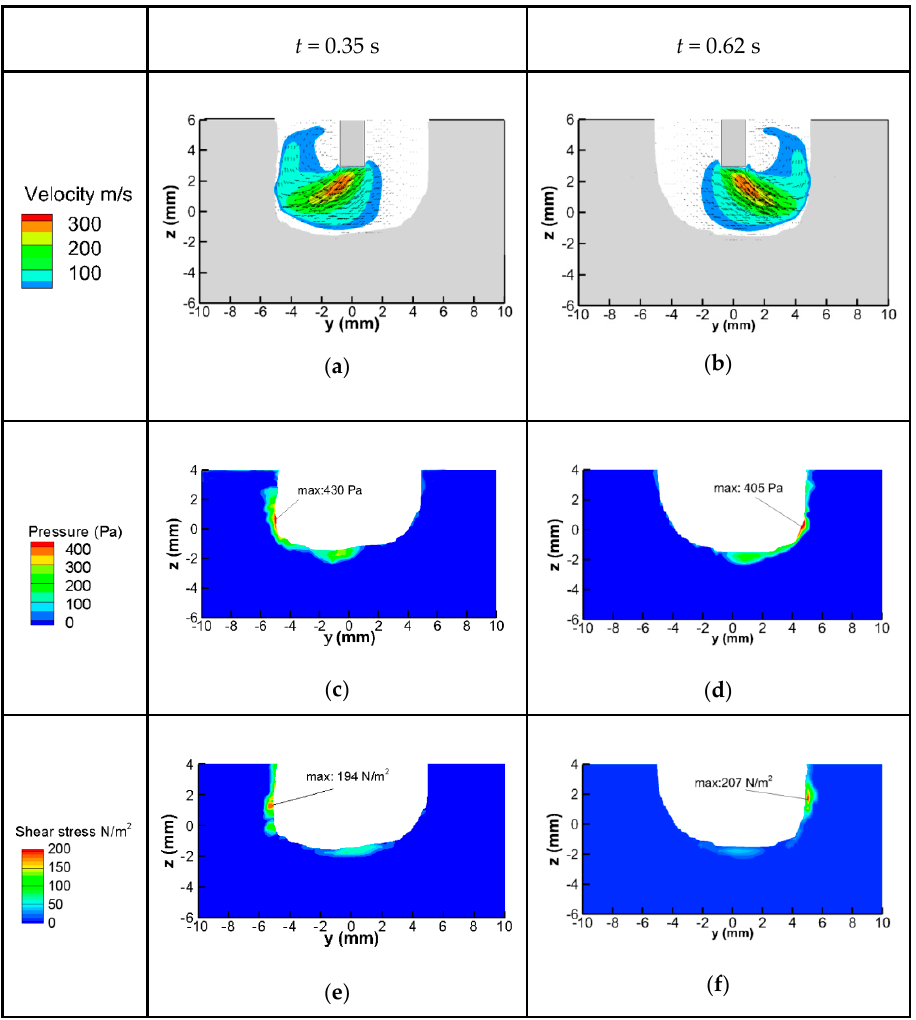
Figure 8. Distribution of welding arc velocity, the arc pressure and shear stress at x = 0 section: ( a , b ) Welding arc velocity; ( c , d ) Arc pressure; ( e , f ) Shear stress.